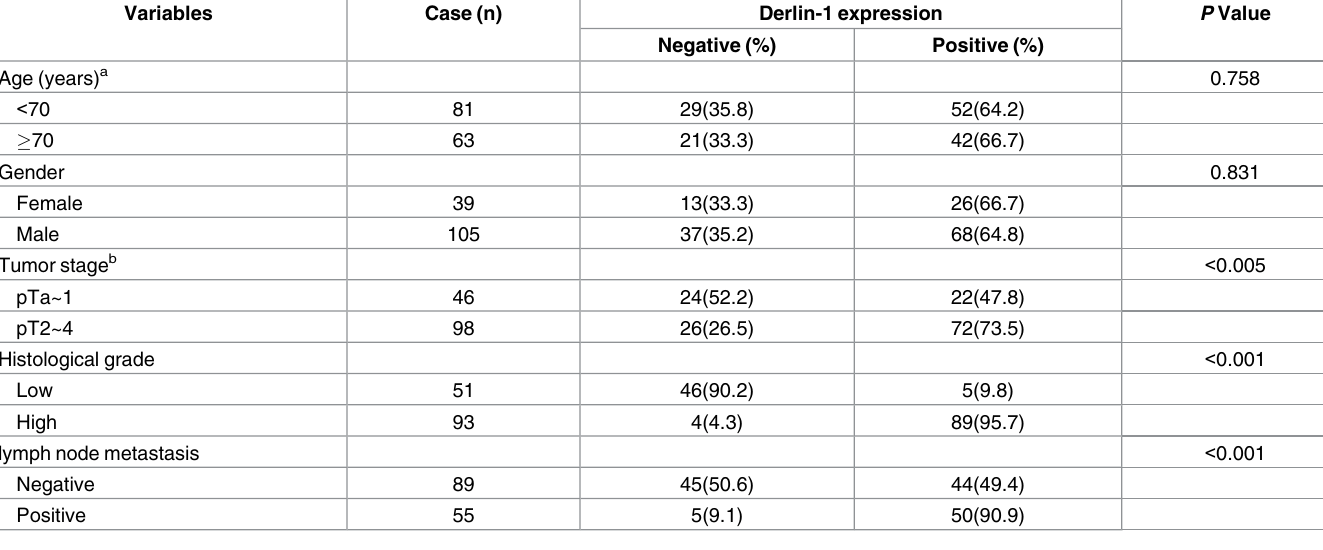
Table 1. Derlin-1 immunohistochemical scores in relation to clinicopathological characteristics